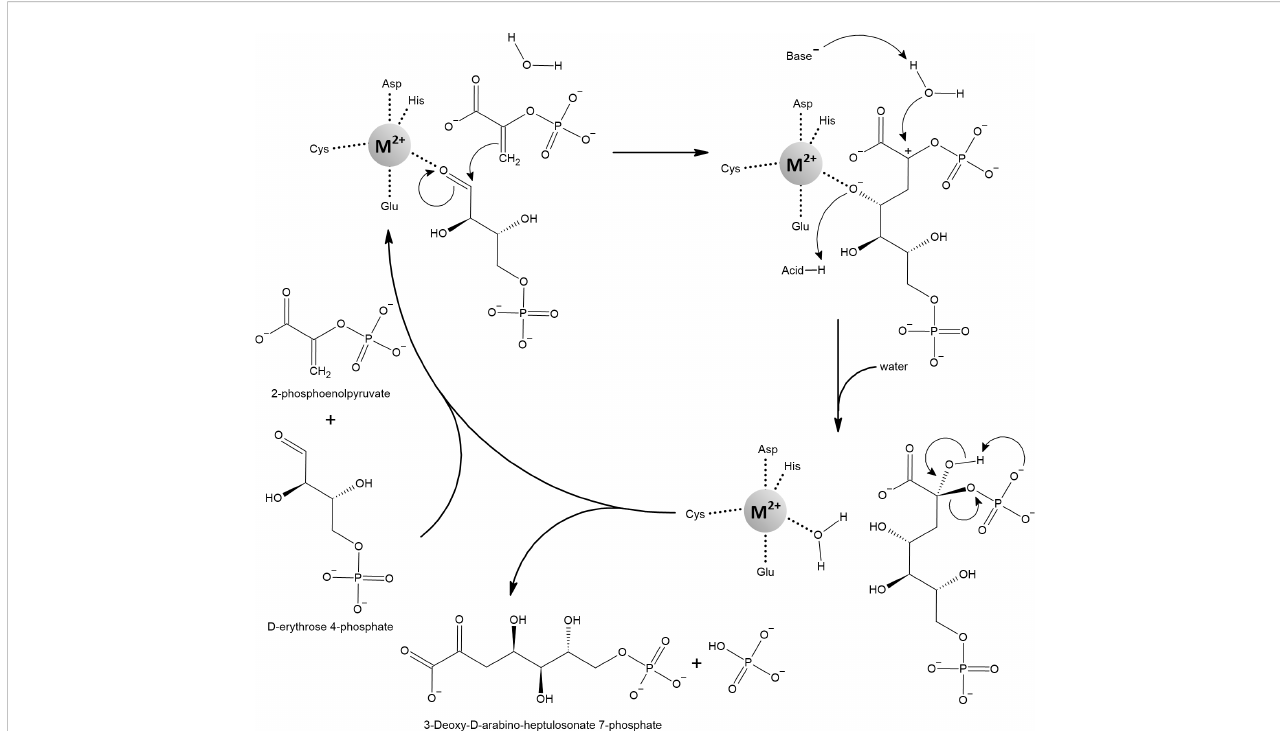
FIGURE 11 3-deoxy- D -arabinoheptulosonate-7-phosphate synthase (DAHP) catalyzes the aldol-like condensation reaction of 2-phosphoenolpyruvate (PEP) and D -erythrose-4-phosphate (E4P). It has been proposed that the metal ion acts as an electrophile that, by coordinating the oxygen of the aldehyde group of E4P, activates the aldehyde carbon for nucleophilic attack by the enol group of PEP. In the next step, the water molecule attacks the partially positively charged C2 of the former PEP. This is likely facilitated by proton abstraction from the active water molecule by nearby aspartate or glutamate and by concomitant protonation of the metal-coordinated oxygen. Finally, the released product reorganizes to cleave off the phosphate group and to form the ketone group instead. A variety of metals can activate DAHP synthases, including Fe 2+ and Mn 2+ . Note that the metal-coordinating glutamate can sometimes bind the metal in bidentate mode, changing the overall geometry to an octahedral shape (Shumilin et al., 1999; Furdui et al., 2004; König et al., 2004; Shumilin et al.,